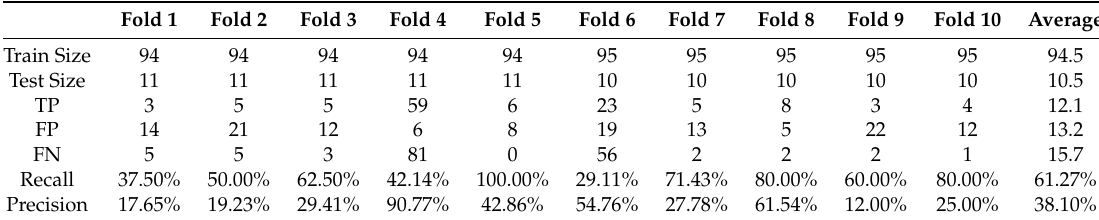
Table A7. The Results of Experiment 7: Adding images without dents (Dataset 1), with a larger number of epochs.